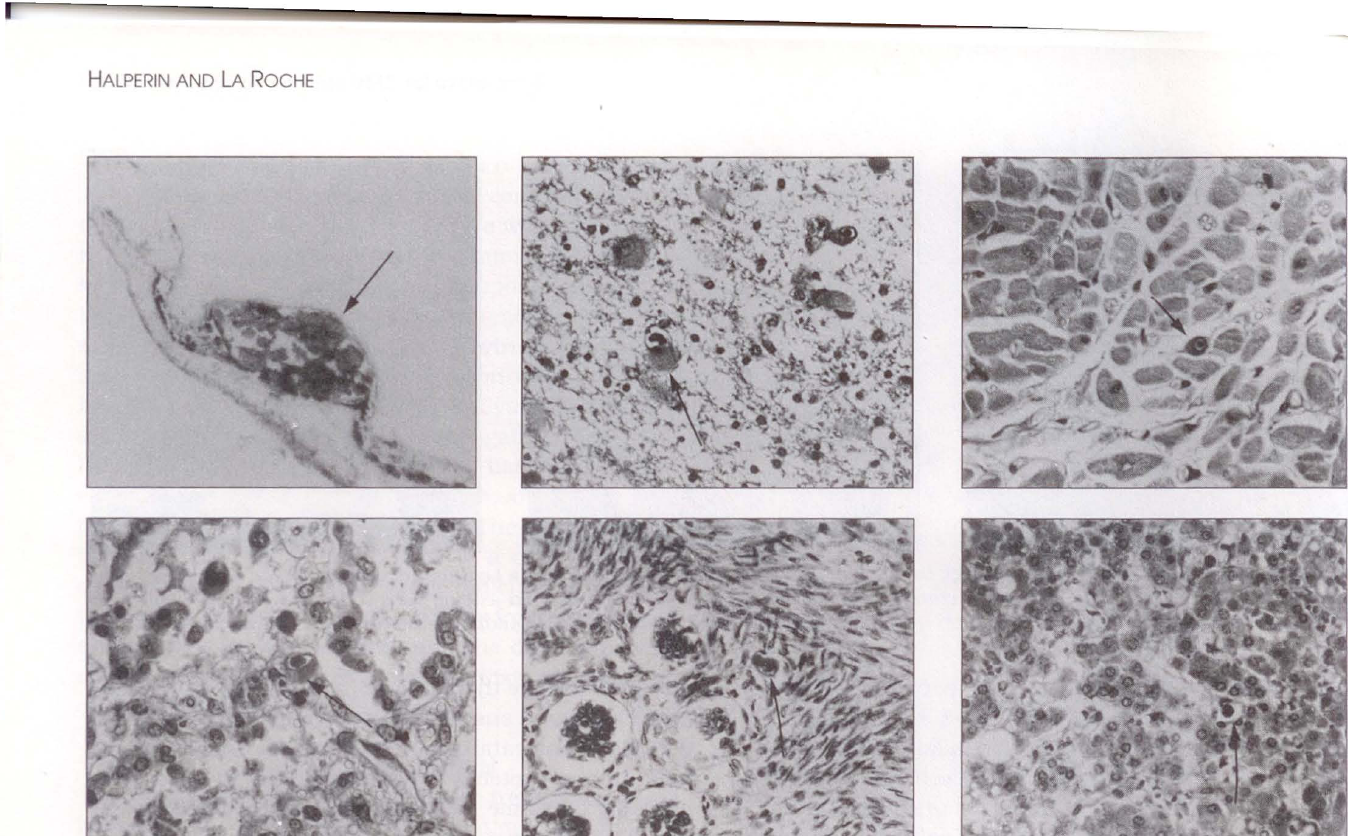
Figure 2) Histological involvement with CMV infection (hematoxylin and eosin stain). Top left Endstage calcijlcation (arrow) of the retina reflects severe damage to the eye caused by CMV (60x). Top centre Periventricular destruction associated with giant astrocytes, often with CMV intranuclear inclusions (arrow) (250x). Top right CMV inclusions (arrow) in myocytes of the heart (250x). Bottom left Diffu.se alveolar pulmonary damage with CMV inclusion (arrow) (250x). Bottom centre CMV inclusions (arrow) in bowel. probably in endothelium of submucosal capillary (250x). Bottom right Hepatic inclusions (arrow) associated with extensive fatty change, lobular disarray, and degeneration